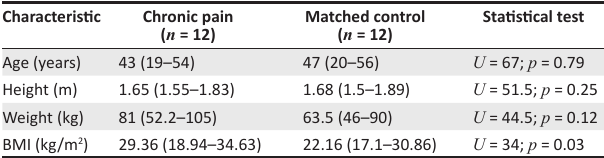
TABLE 1: Physical characteristics of participants ( N = 24). Characteristic